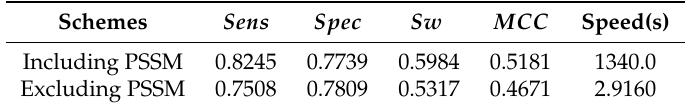
Table 6. Performance comparison of the schemes excluding and including